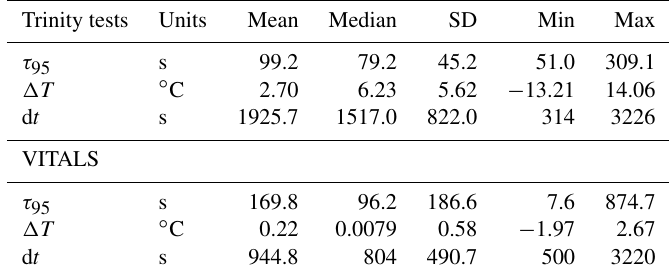
Table 2. Response time values from glider-based CO 2 optode tests. Trinity tests Units Mean